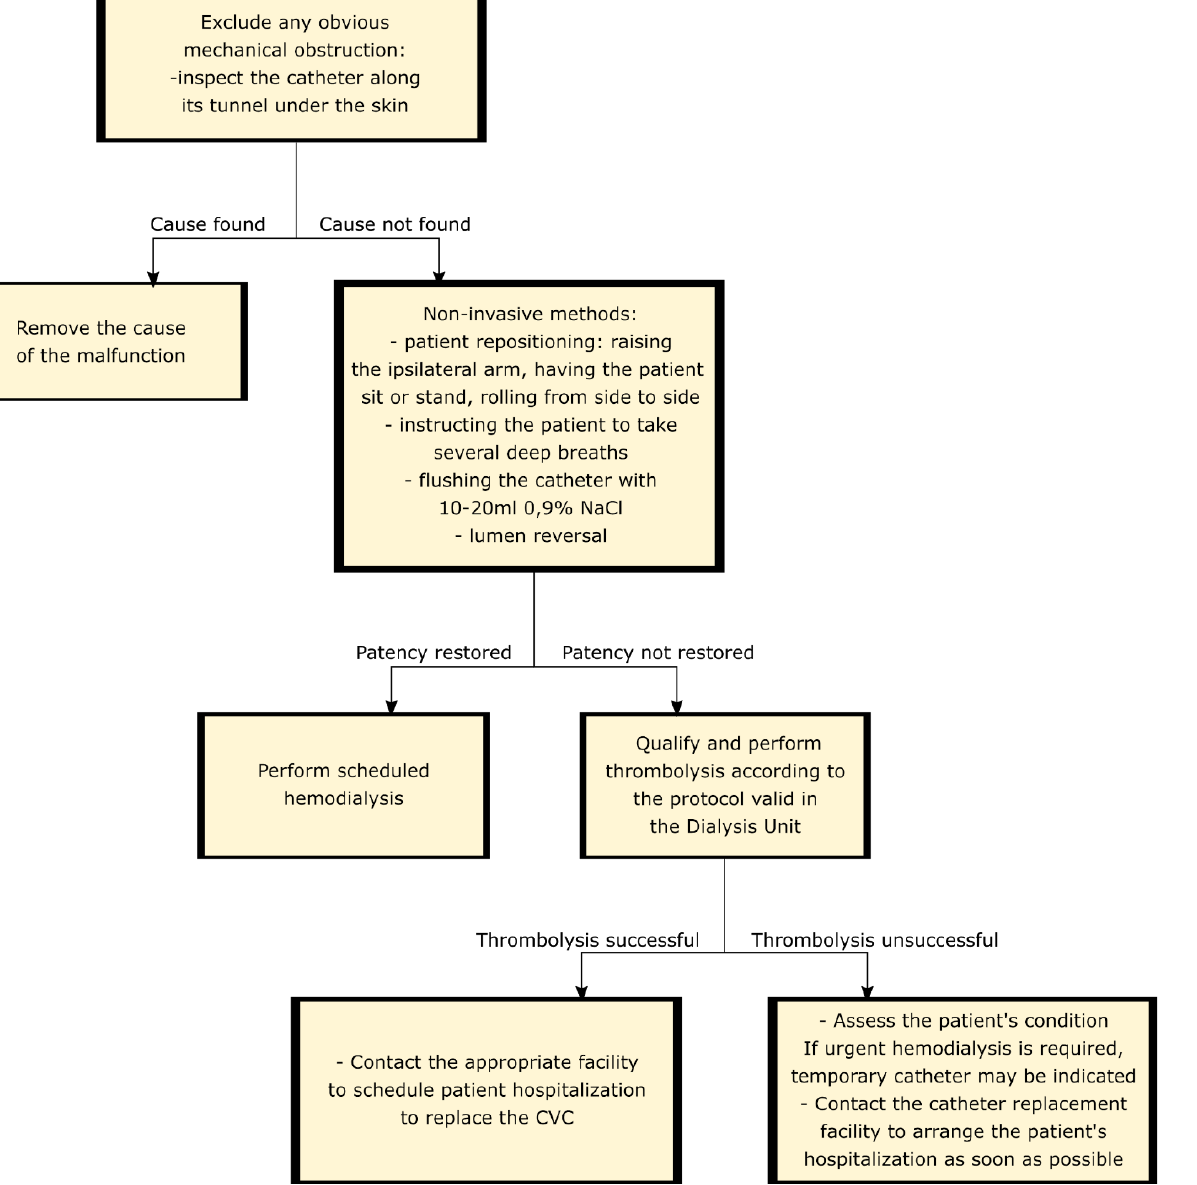
Figure 3. Exemplary scheme of conduct in case of catheter malfunction.